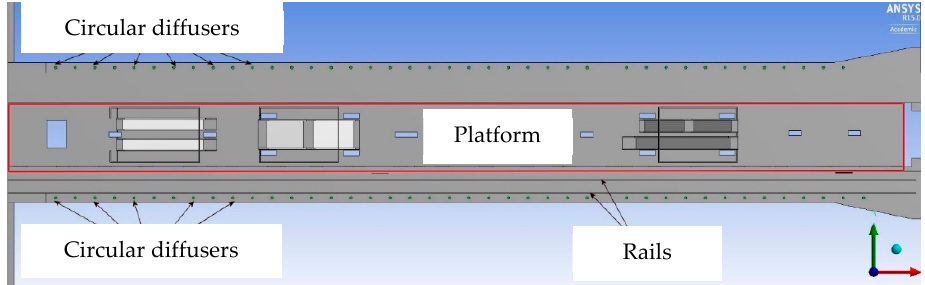
Figure 6. Over track ventilation system in the subway station.